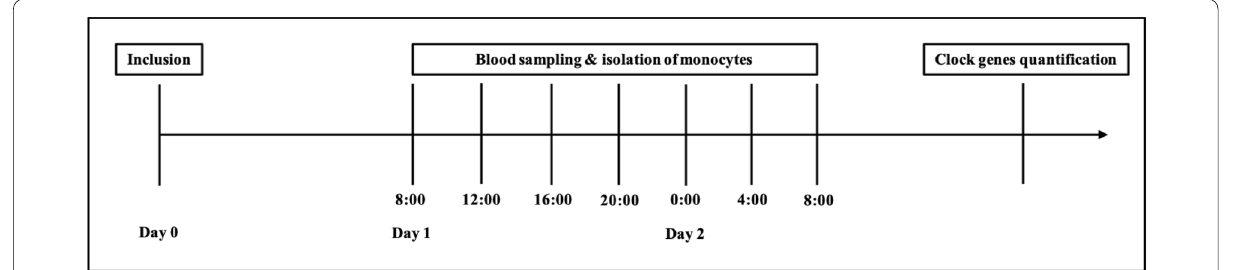
Fig. 1 Study schedule from inclusion, over blood sampling and isolation of monocytes to gene